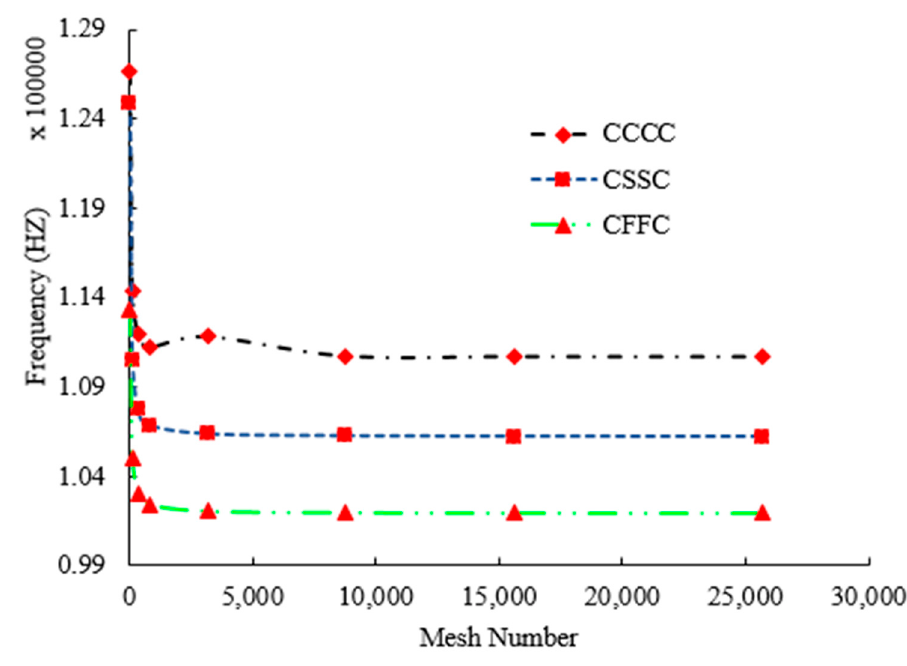
Figure 2. Mesh convergency for the finite element (FE) panel model.